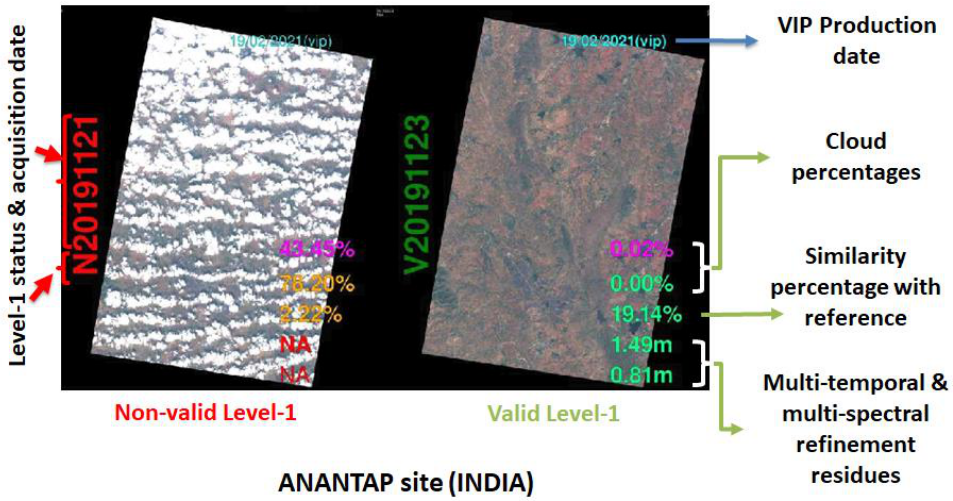
Figure 49. Correlation with reference: statistics for monitoring.